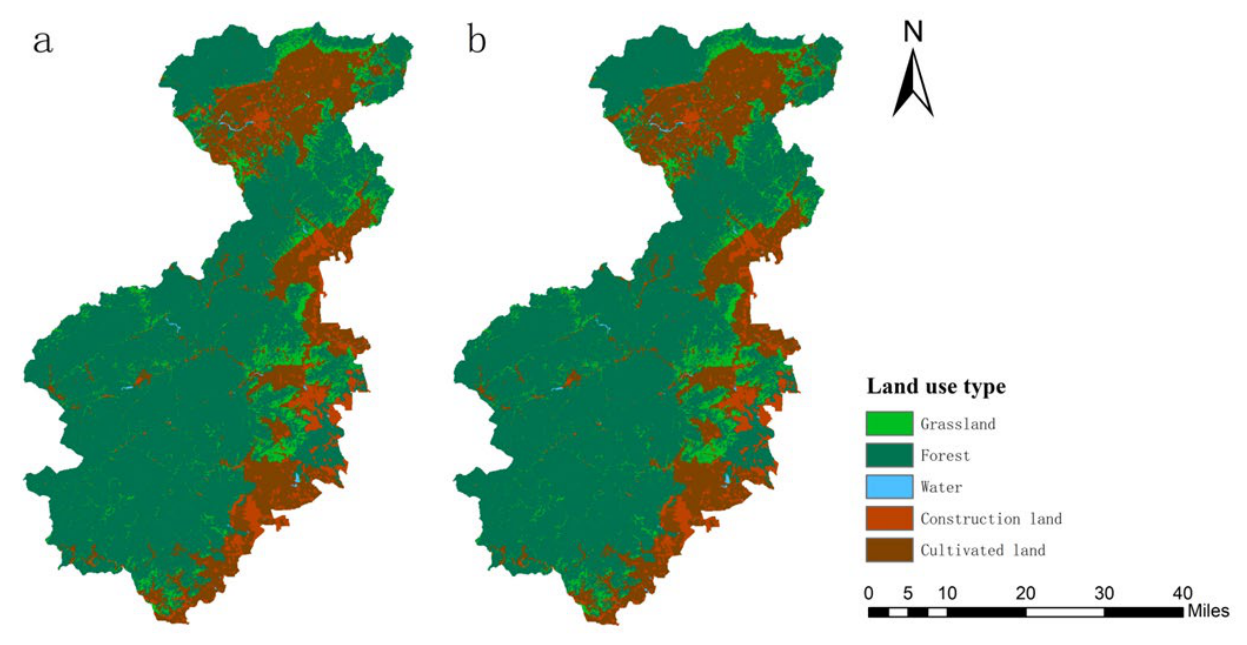
Beijing in 2020. Figure 5. Land-use simulation maps of: ( a ) PLUS model; ( b ) FLUS model in the ECA of western